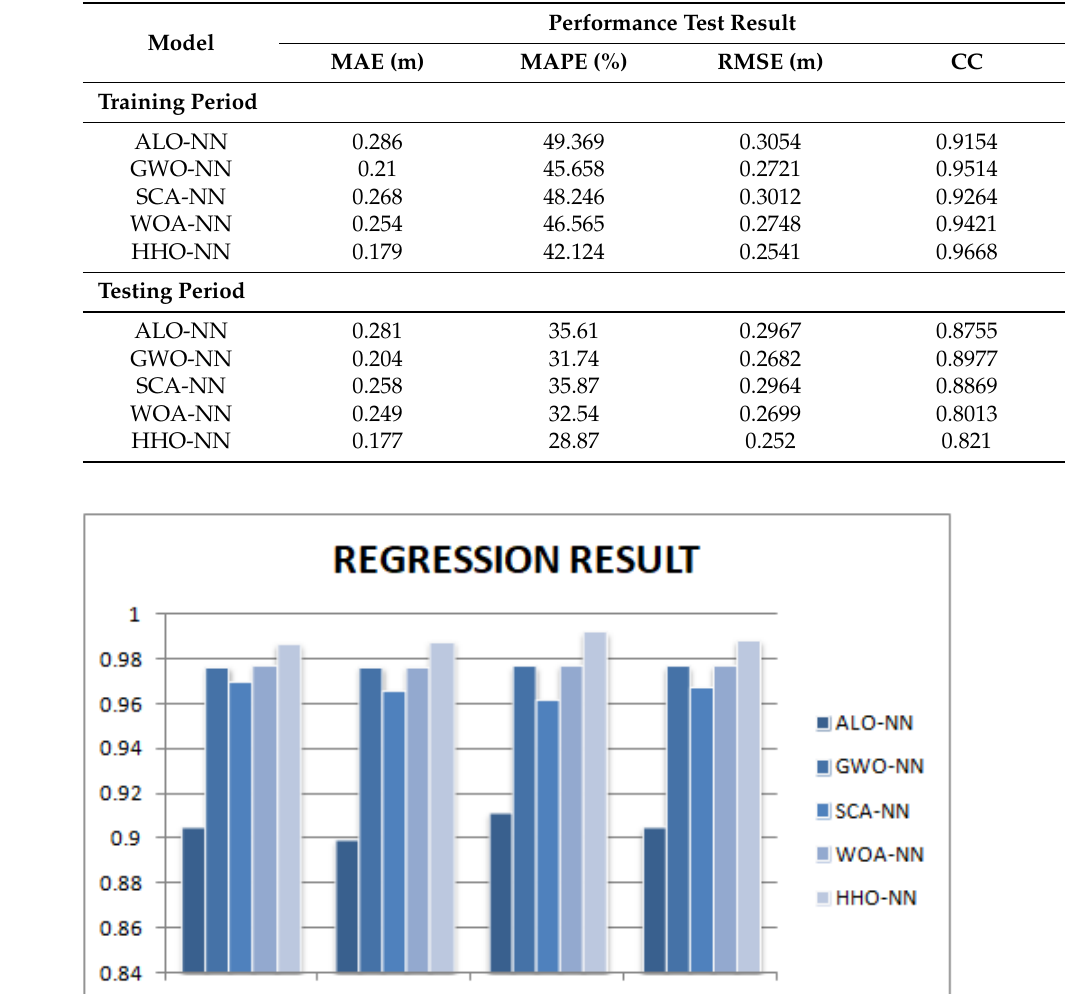
Table 1. Performance Test Results.